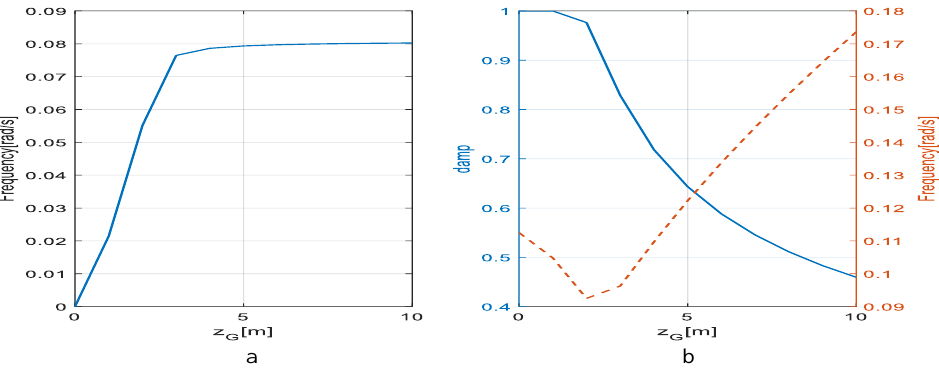
Figure 11. Curve of Influence of Vertical Mass Center Perturbation on Motion Mode of Pitching Channel: ( a ) frequency characteristic curve of the first-order inertia damping mode of the pitching channel affected by the vertical perturbation of the mass center, ( b ) damping and frequency characteristic curves of the second-order oscillation convergence mode of the pitching channel affected by the vertical perturbation of the mass center.